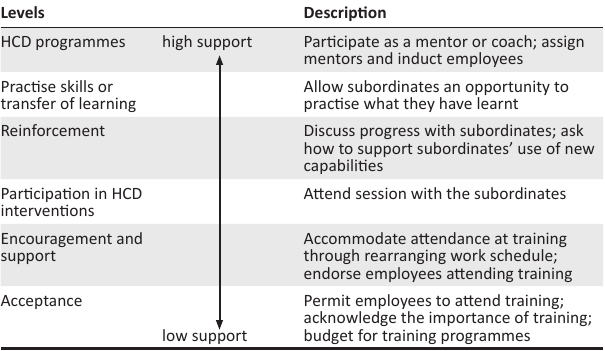
TABLE 1: Levels of management support for